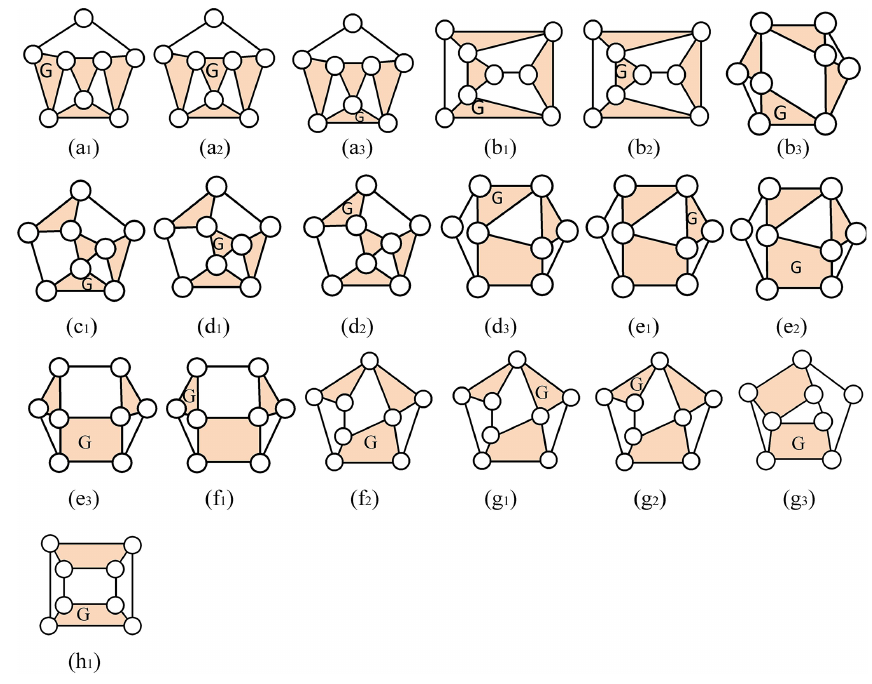
Figure 12. Specialized chains atlas of (6, 8) with assigned ground link.